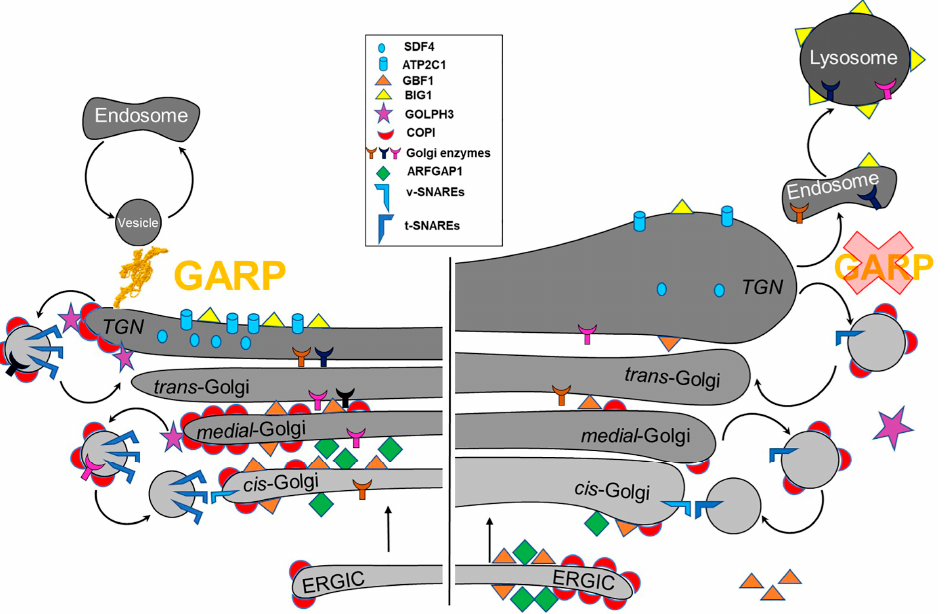
Figure 4. GARP dysfunction results in the depletion and mislocalization of multiple Golgi proteins, altering Golgi homeostasis. ( Left ) A schematic of Golgi proteins in wild type cells. ( Right ) GARP de fi cient cells are depleted for multiple resident Golgi proteins. COPI coats and ARFGAP1 are mis- localized to ERGIC., while BIG1 is relocated to endolysosomal compartments.